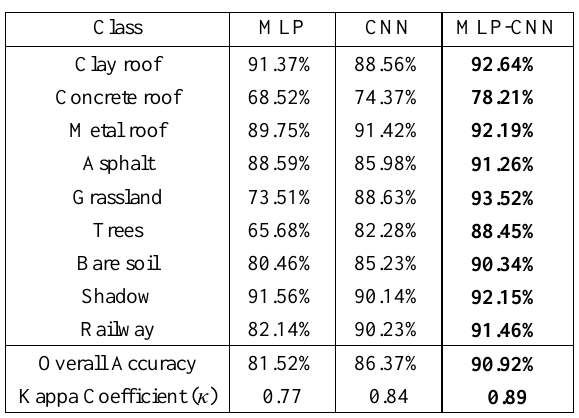
Table 1. Classification accuracy comparison amongst MLP, CNN and the proposed MLP-CNN approach for Bournemouth using the per-class mapping accuracy, overall accuracy (OA) and Kappa coefficient ( κ ). The bold font highlights the greatest classification accuracy per row.